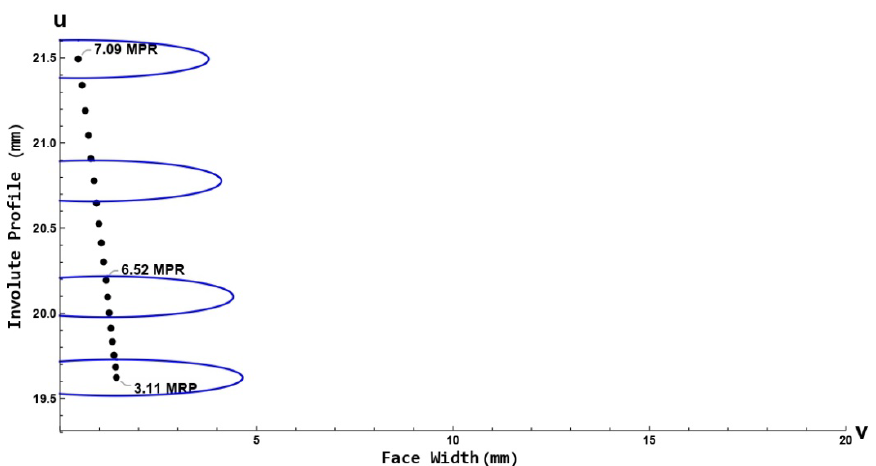
Figure 24. The MPR of crowned helical gears with a minimum amount of circular modification along the path of contact for an out-of-plane misalignment of 0.2° (3.5 mrad), where the blue outlines demonstrate the location of contact ellipse at the contact point.